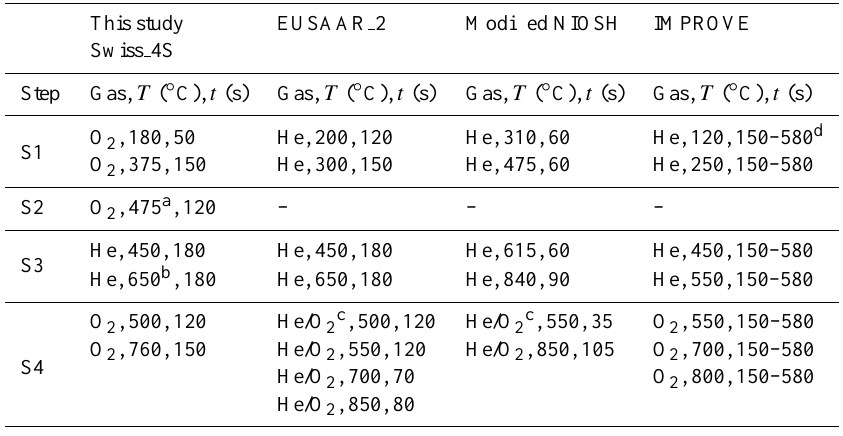
Table 2. Parameters (carrier gas, temperature set point and duration) of the Swiss 4S protocol compared to the EUSAAR 2, modified NIOSH and IMPROVE protocols. This study EUSAAR 2 Modified NIOSH IMPROVE Swiss 4S